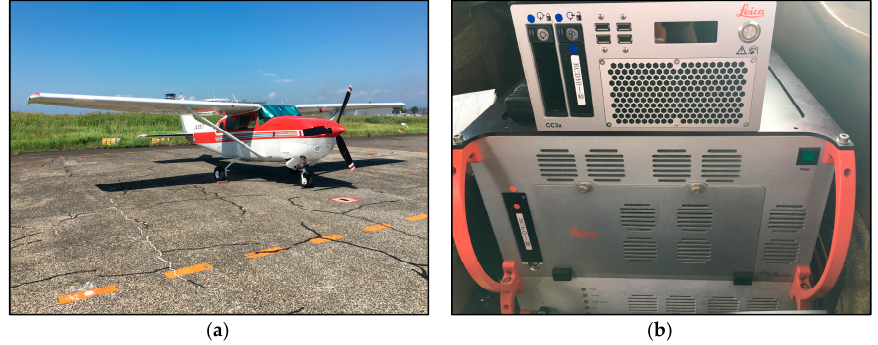
Figure 18. Aerial surveillance system description: ( a ) the aircraft used for aerial data collection; and ( b ) the sensor setup for the aerial imagery. Table 1. Details of the sensor platforms employed for the